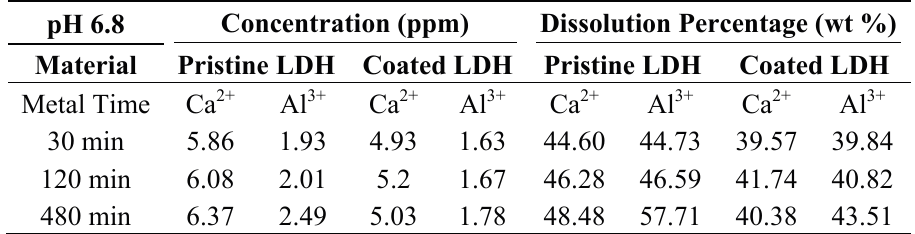
Table 2. Time dependent Ca 2+ dissolution of CaAl-LDH and E-coated CaAl-LDH at pH 6.8.